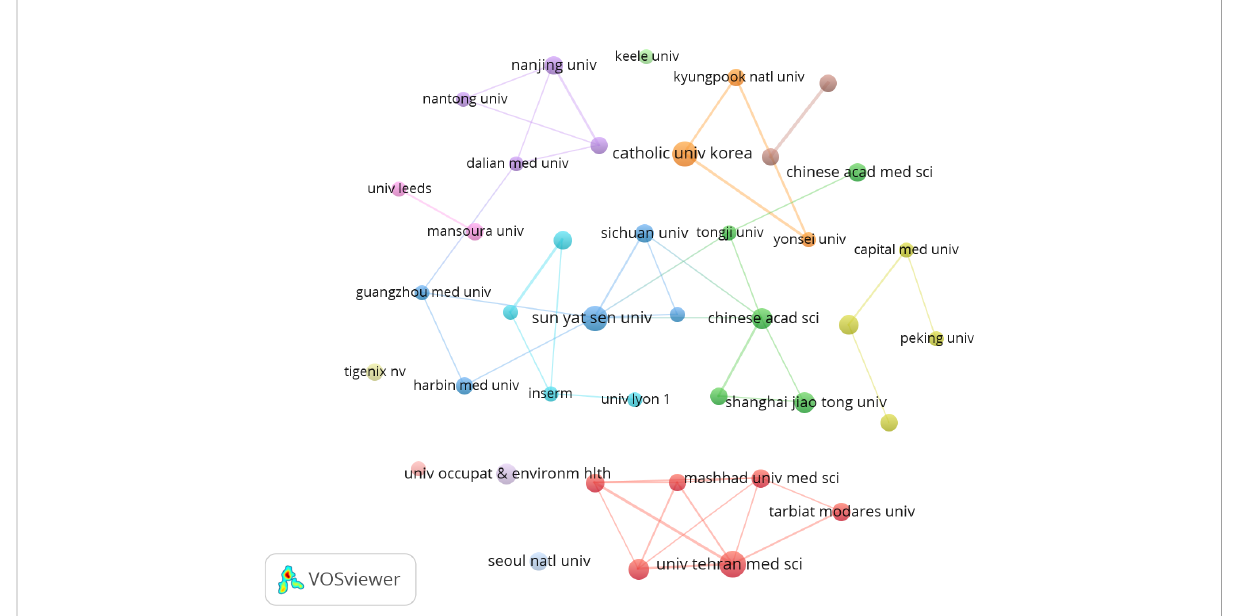
FIGURE 4 Visualization of organizations related to MSCs and RA publications.